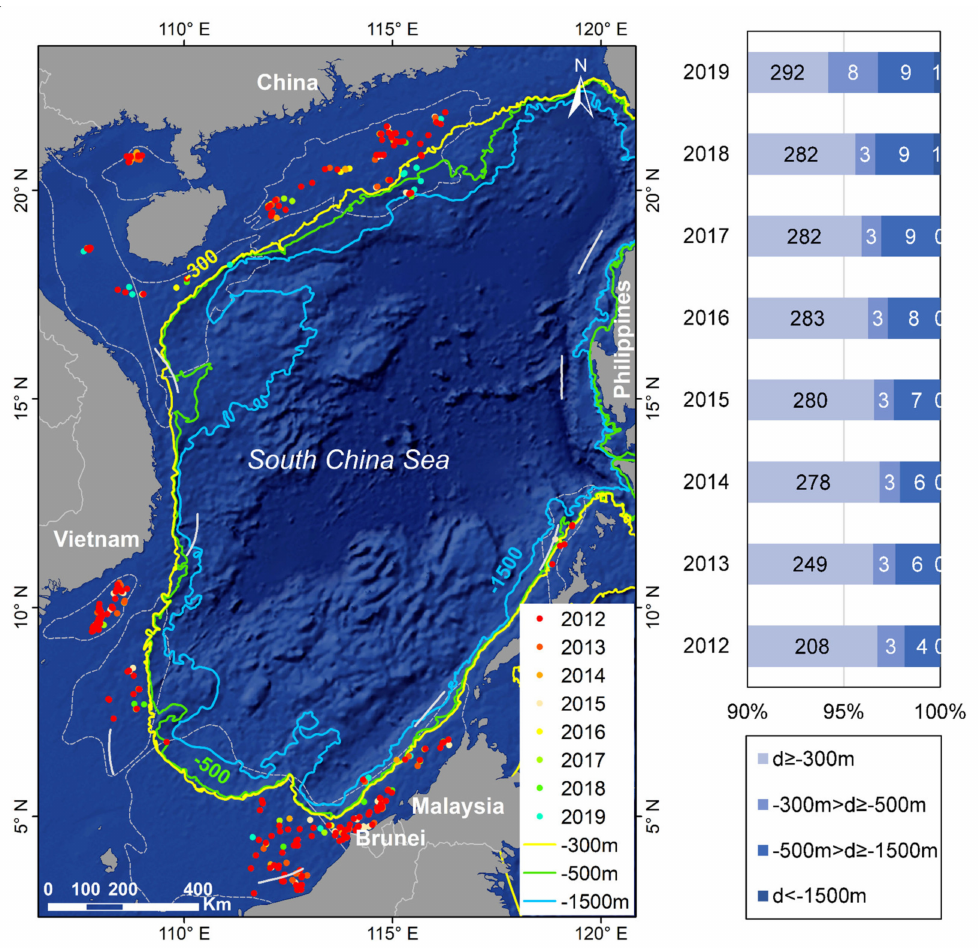
Figure 13. Spatio-temporal changes in the quantity of HE targets in different exploitation depth levels from 2012 to 2019.